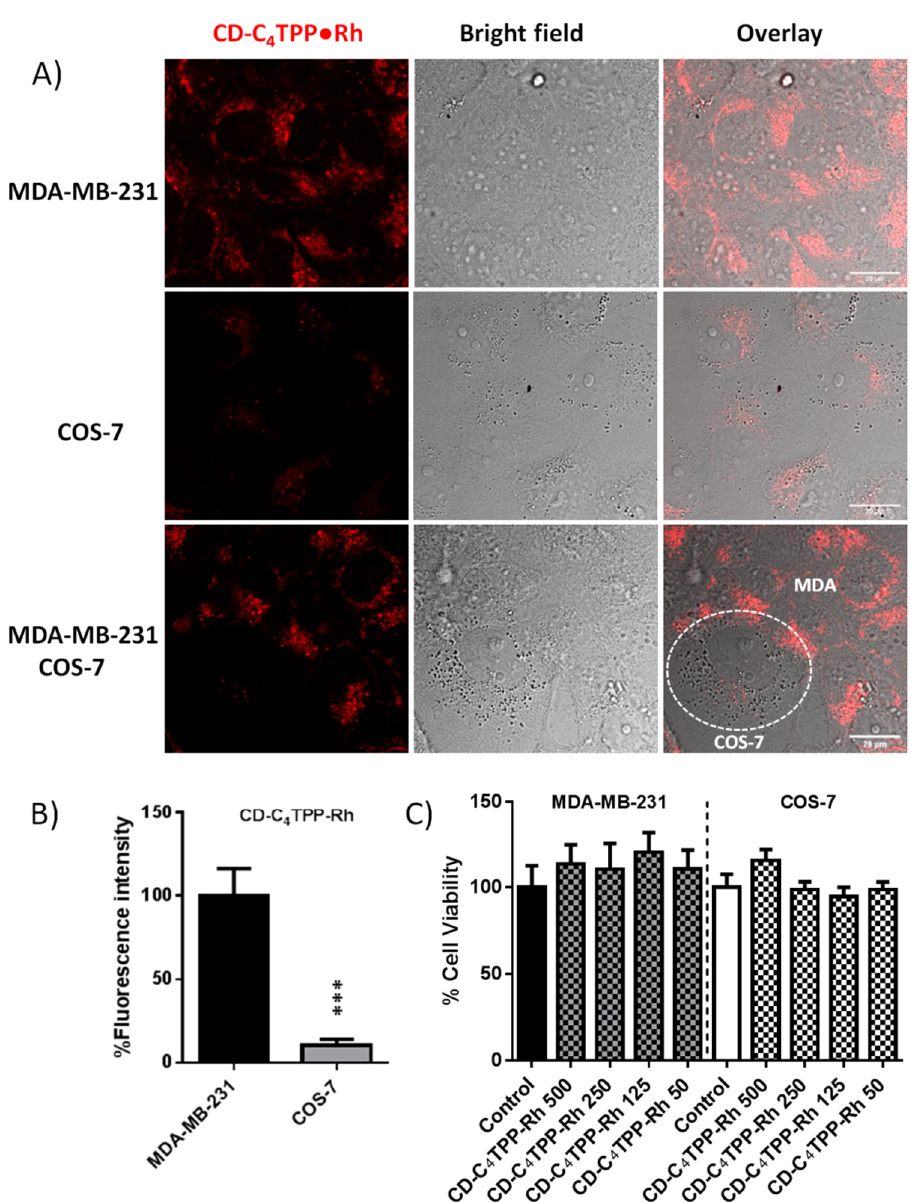
Figure 8. ( A ) Comparison of CD-C4TPP • Rh internalization in live COS-7 and MDA-MB-231 cells, as well as in co-culture of both cell lines. Cells were treated with 50 µ g/mL of CD-C4TPP • Rh for 24 h. Overlay depicts bright field and red channel. Scale bar: 20 µ m. ( B ) Fluorescence quantification (%) of different internalization intensities between cell lines. ( C ) Cytotoxicity of CD-C4TPP • Rh in MDA-MB-231 cells and COS-7 cells. Cells were treated with increasing concentrations (50–500 µ g/mL) of CD-C4TPP • Rh for 24 h. Cell viability was assessed by the MTT assay. Results are expressed as the mean ± standard error for at least three independent experiments and were analyzed using